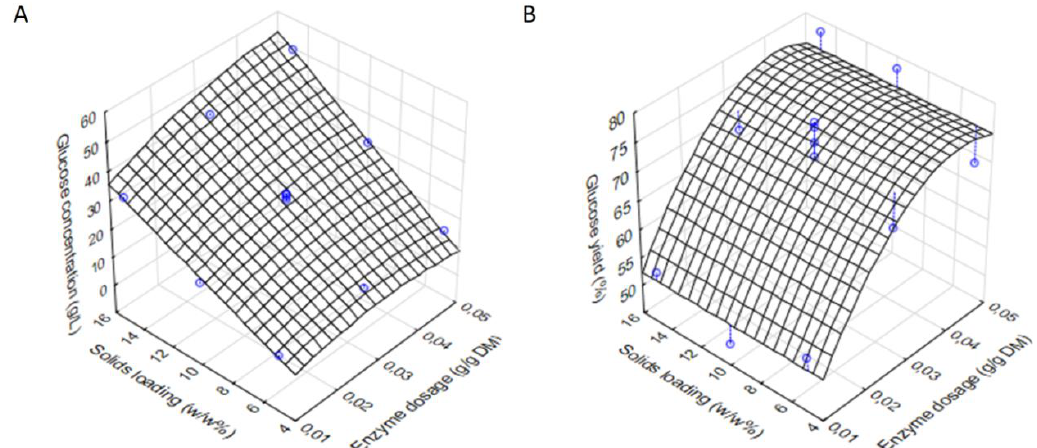
Figure 3. Fitted surfaces of glucose concentration ( A ) and glucose yield ( B ) obtained in designed experiments of the enzymatic hydrolysis step.